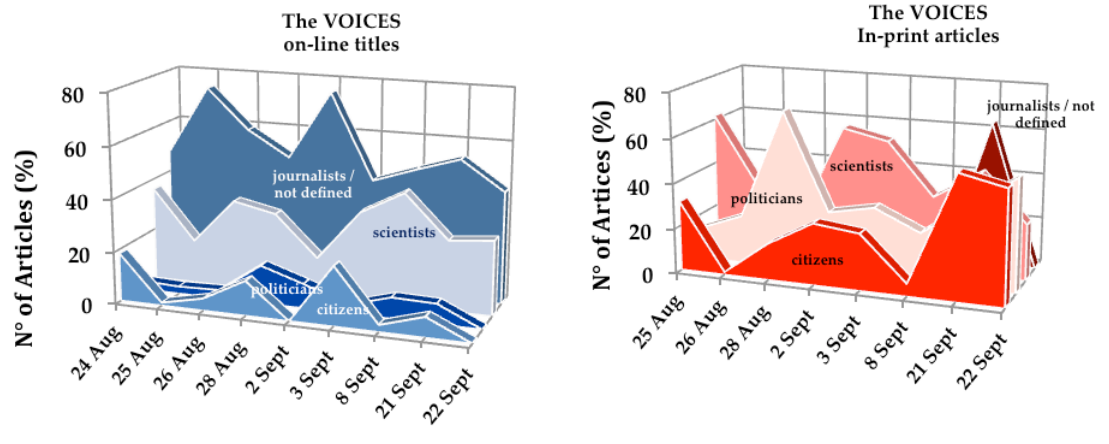
Figure 5. Who is really speaking? The VOICES indicators acknowledge scientists or experts as the real speaker in 51% of the stories. Citizen are the most unspoken